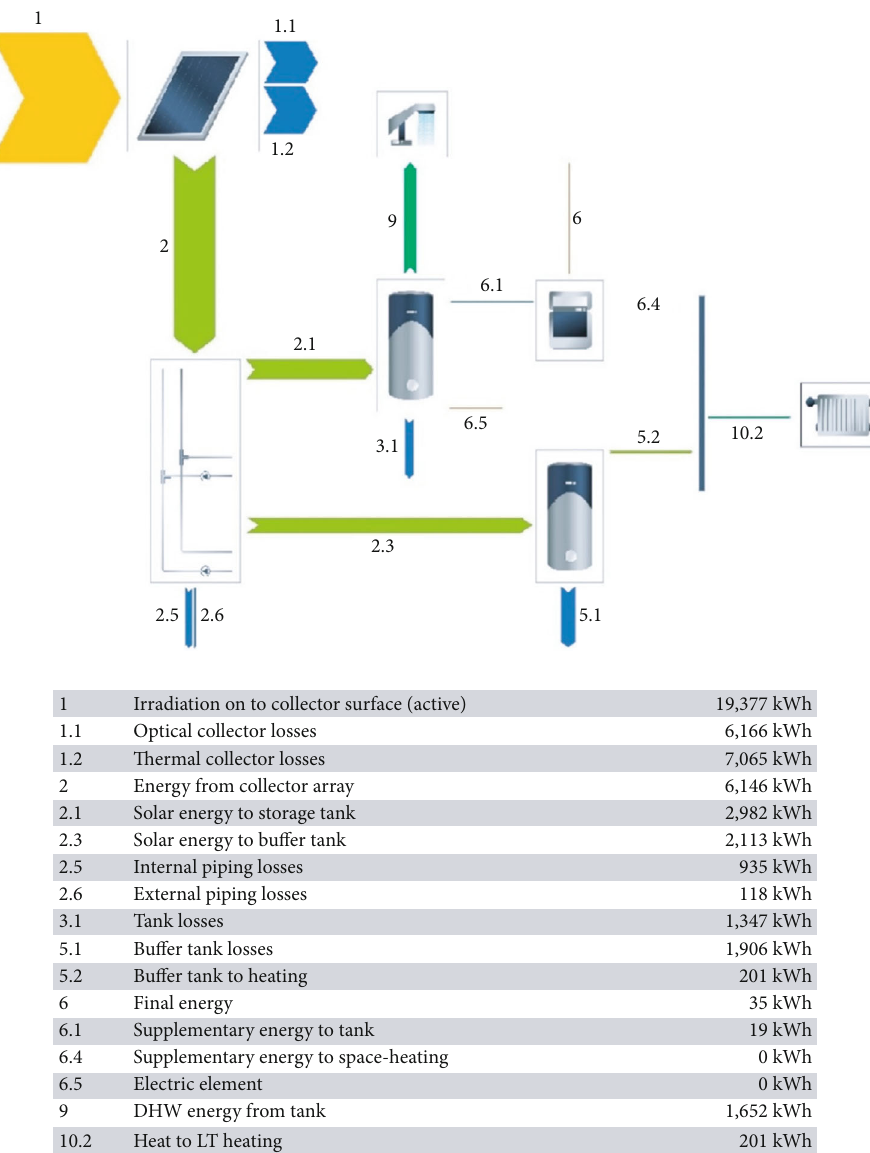
Figure 9: Energy balance schematic for Sesheke Town. DHW: domestic hot water; LT: low